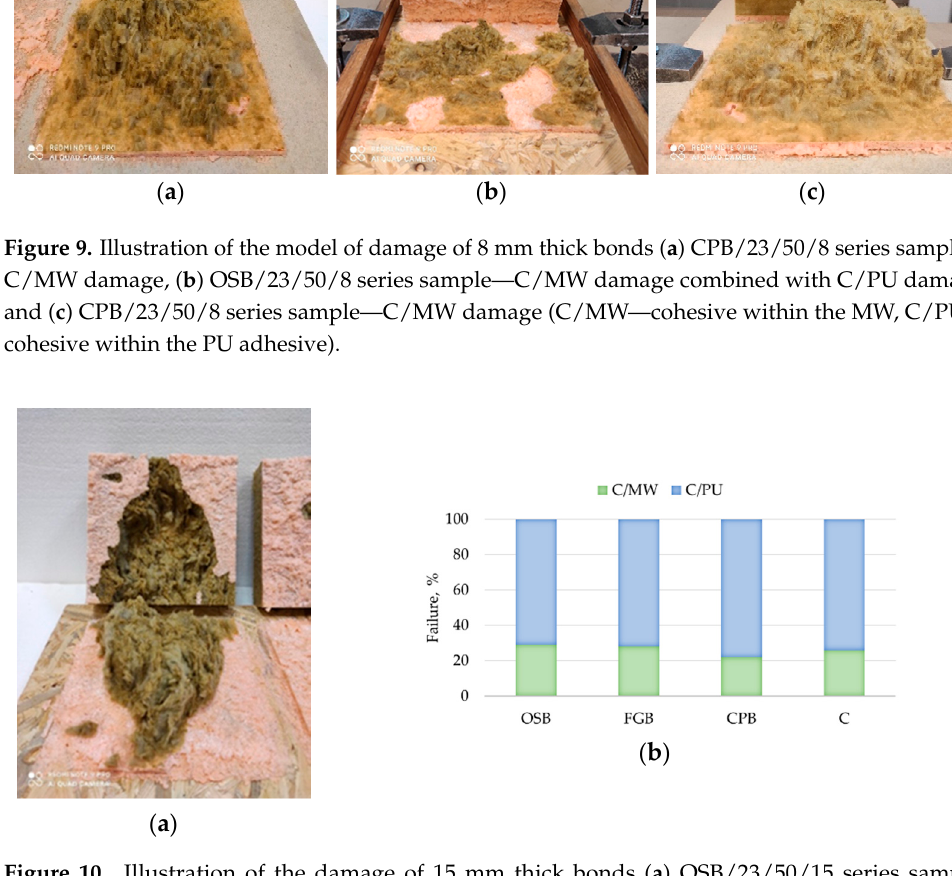
Figure 10. Illustration of the damage of 15 mm thick bonds ( a ) OSB/23/50/15 series sample, ( b ) average values for individual series (C/MW—cohesive damage of the MW, C/PU—cohesive damage of the PU adhesive).